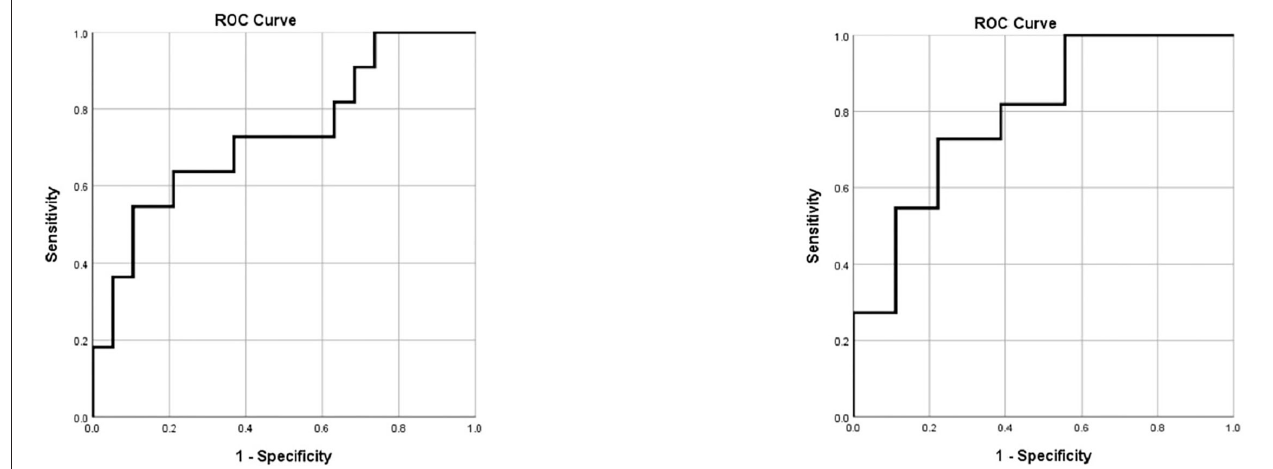
FIGURE 2 | ROC curves for the prediction of EVD associated infections. Left: ROC curve for the prediction of EVD associated infection according to body temperature and blood serum markers alone. Right: ROC curve for the prediction of EVD associated infection according to body temperature, blood serum markers and CSF parameters. CSF, cerebrospinal fluid; EVD, external ventricular drainage; ROC, receiver operating